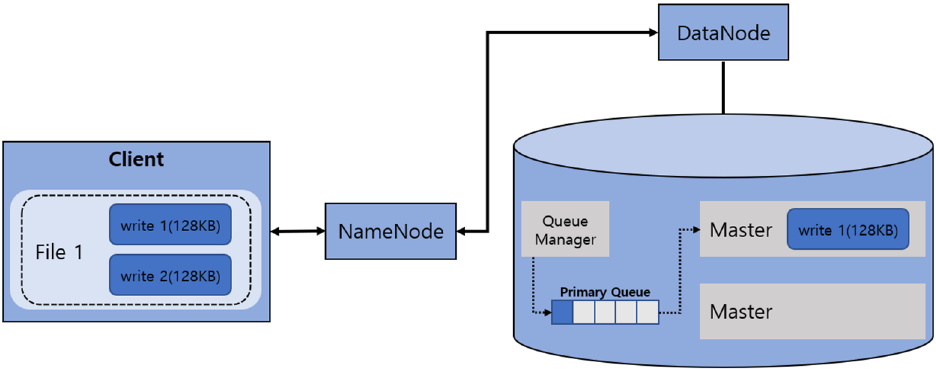
Figure 1. Single input/output (I/O) process in erasure coding (EC)-based Hadoop distributed file system (HDFS).